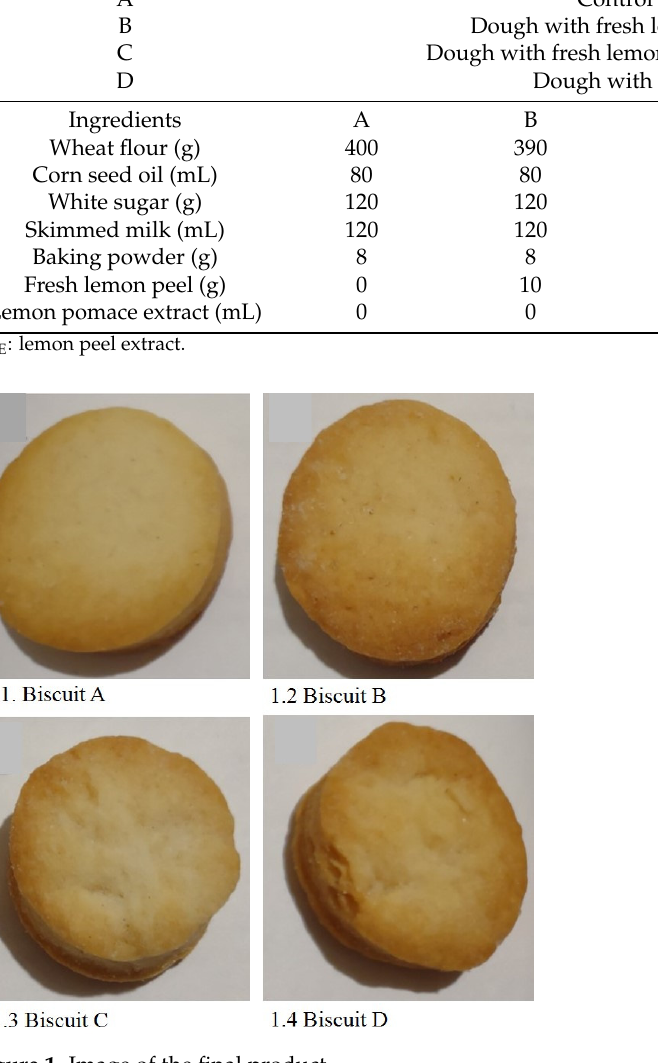
Figure 1. Image of the final product.